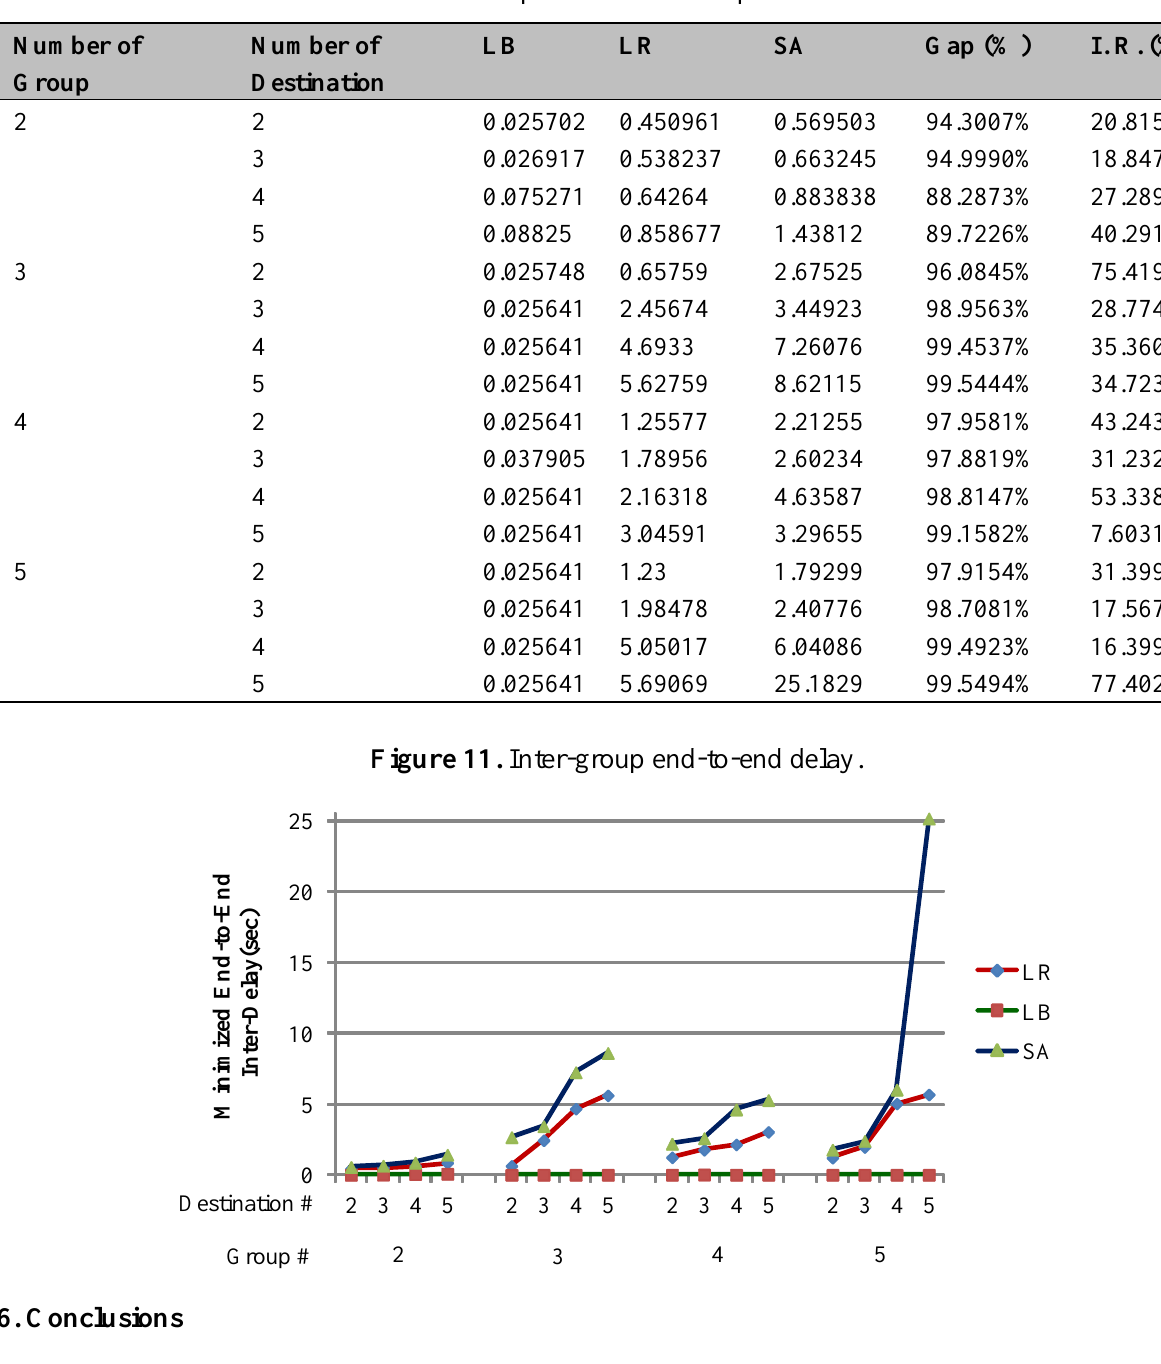
Table 5. Experiment result explanation.